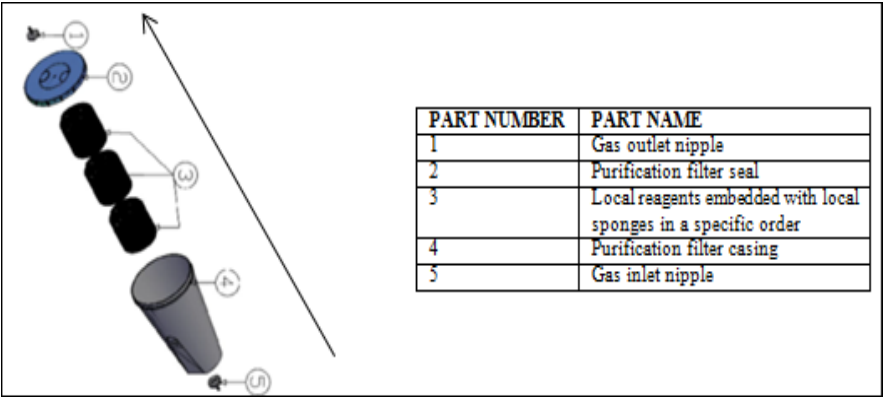
Fig. 3. Design concept three